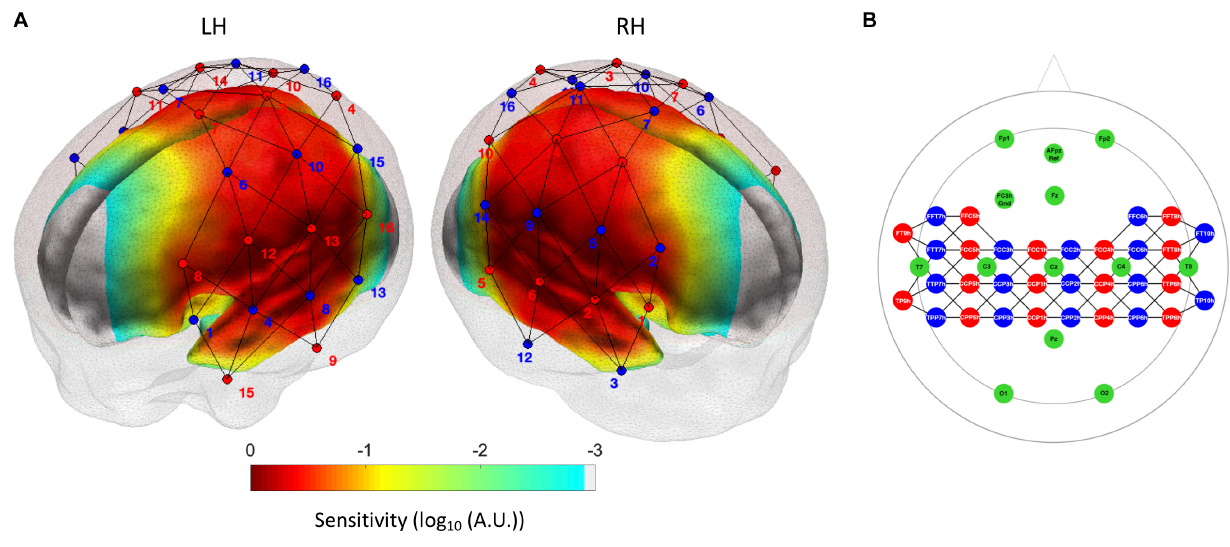
of our cap arrangement on a representative participant).